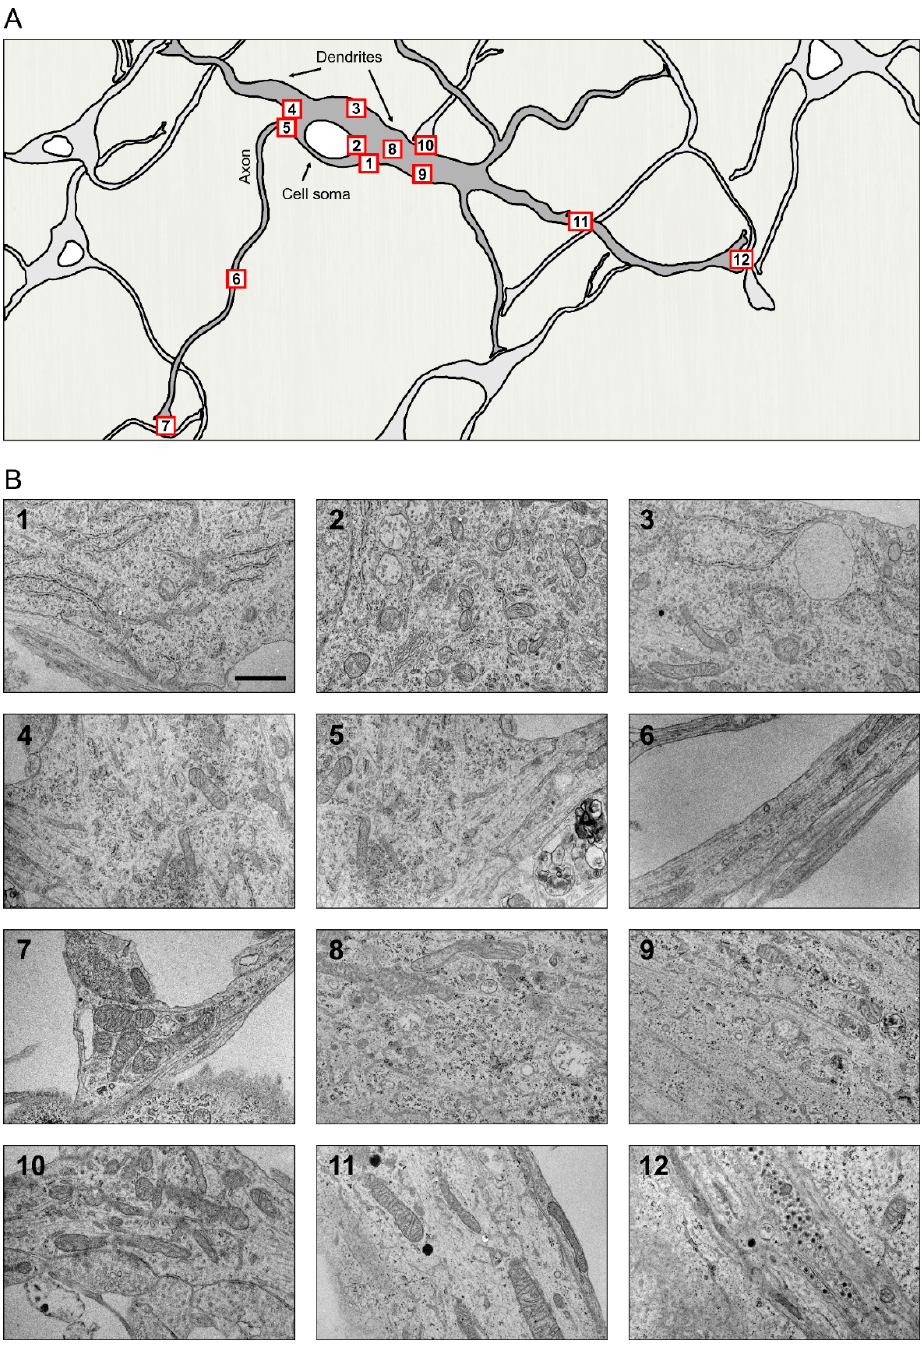
Figure 3. Neuronal ER comes with different shapes and interaction partners throughout the cell. ( A ) A schematic drawing of a neuron comprising soma, axon and dendrites. Numbered boxes in the drawing denote area, where the corresponding micrograph in ( B ) is taken. ( B ) Thin section transmission electron micrographs from various areas from a cultured primary midbrain dopaminergic neuron from postnatal mice expressing GFP under the TH promoter. The ER is visible in all compartments of the neuron. Note the differences in the ER sheets and tubules in the somatodendritic areas compared to various areas of the axon. For interactive image, go to https://www.mv.helsinki.fi/home/ibelev/temp/neuron/ (Accessed 23.4.2021) eMagnification bar, 200 nm.